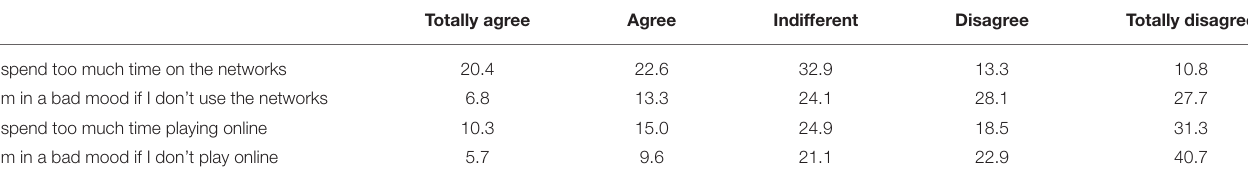
TABLE 2 | Descriptive statistics of variables about the experience of Internet